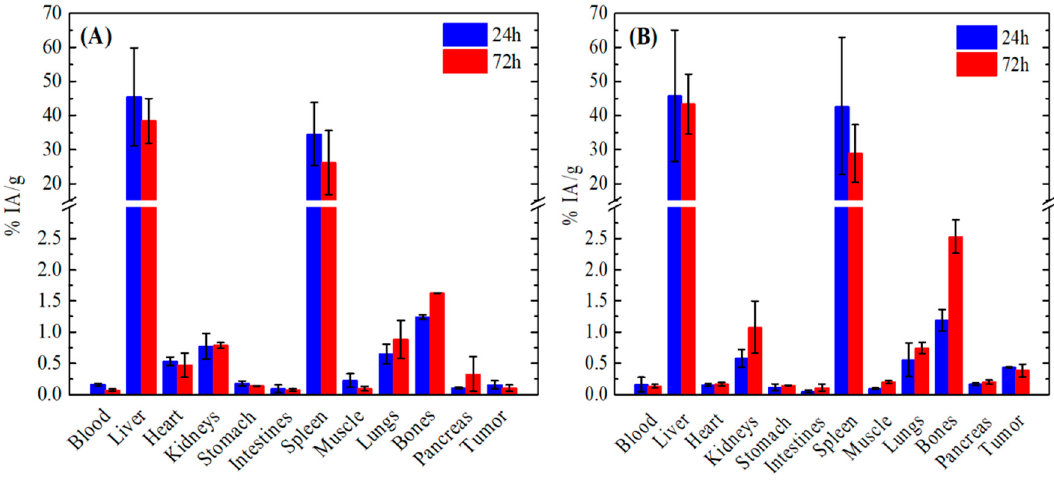
Figure 8. Ex vivo biodistribution data of the ( A ) 177 Lu@Fe 3 O 4 -CEPA and ( B ) 177 Lu@Fe 3 O 4 -CEPA- trastuzumab at 24 h and 72 h p.i. in SKOV-3 tumor-bearing SCID mice. The uptake in each organ is expressed as percentage injected activity per gram of tissue (% IA/g). For each time point, three mice were studied, thus the results are expressed as the mean ±